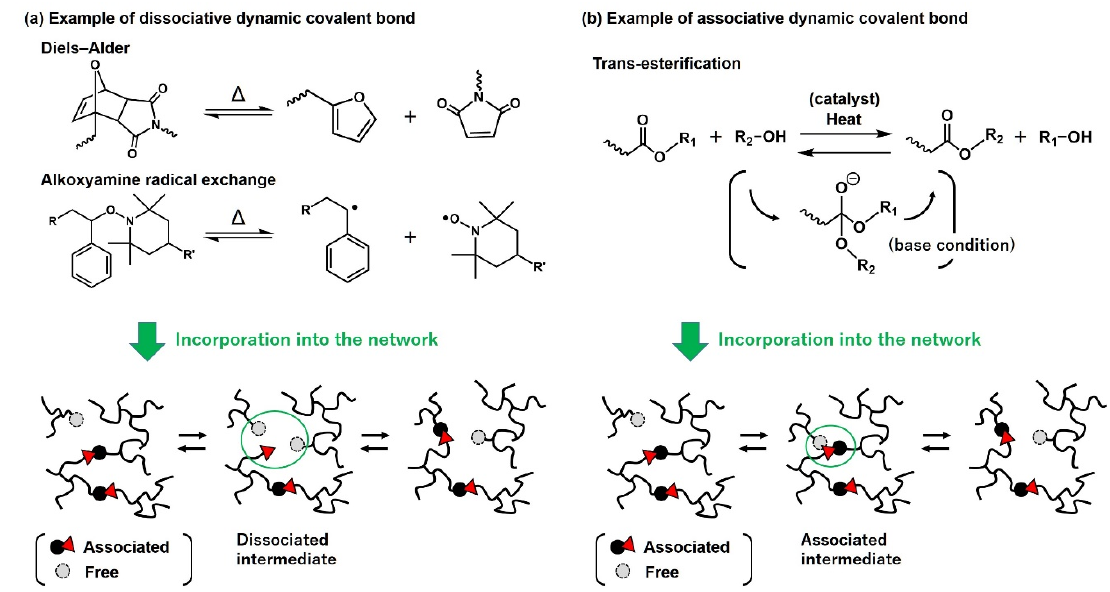
Figure 2. Examples of ( a ) dissociative dynamic covalent bonds and ( b ) associative dynamic covalent bonds, and the schematic for the di ff erence in the bond exchange mechanism in the network.